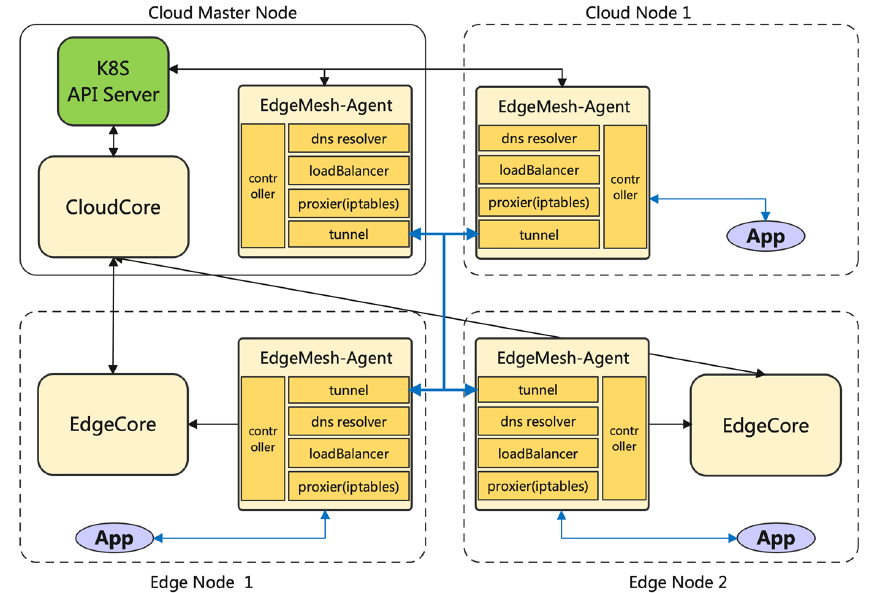
Figure 4. KubeEdge ’s EdgeMesh architecture [67].